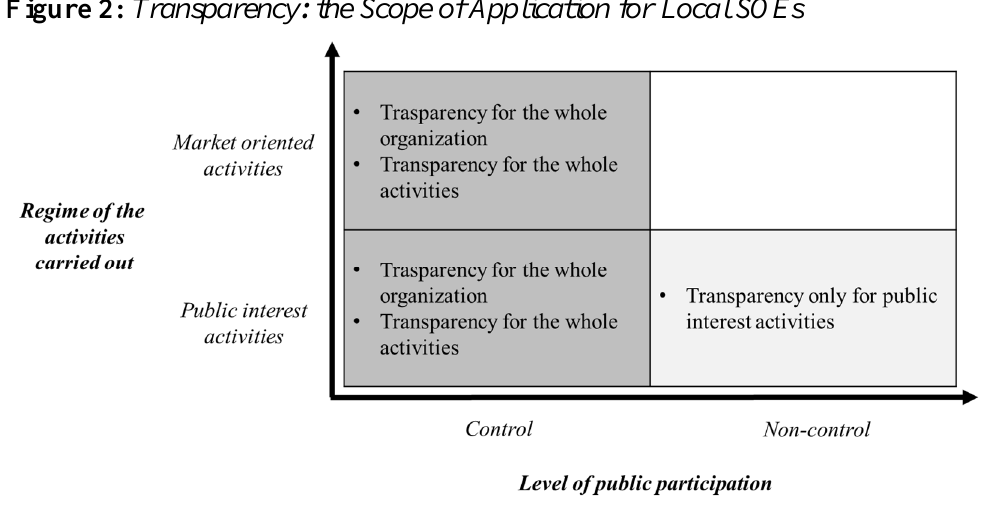
Figure 2: Transparency: the Scope of Application for Local